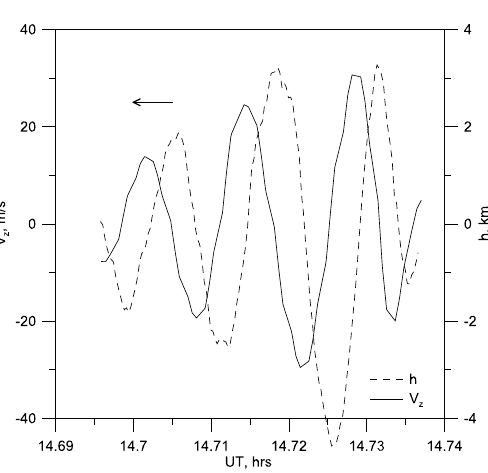
Figure 3. Variations of vertical velocity and displacement on the southern polar segment of the DE2 orbit 8286. The arrow indicates the direction of wave propagation.